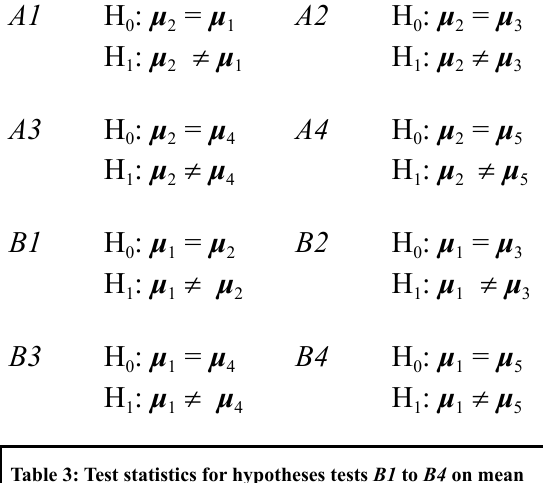
Table 3: Test statistics for hypotheses tests B1 to B4 on mean refractive state using μ 1 as reference value, as well as test statistics for hypotheses tests A1 to A4 on mean refractive state Gillan1 using μ 2 as reference value (same as ). The respective null hypotheses (H 0 ) are that the mean refractive states are equal. Critical values are F0.05, 3, 56 = 2.776, and F0.01, 3, 56 =